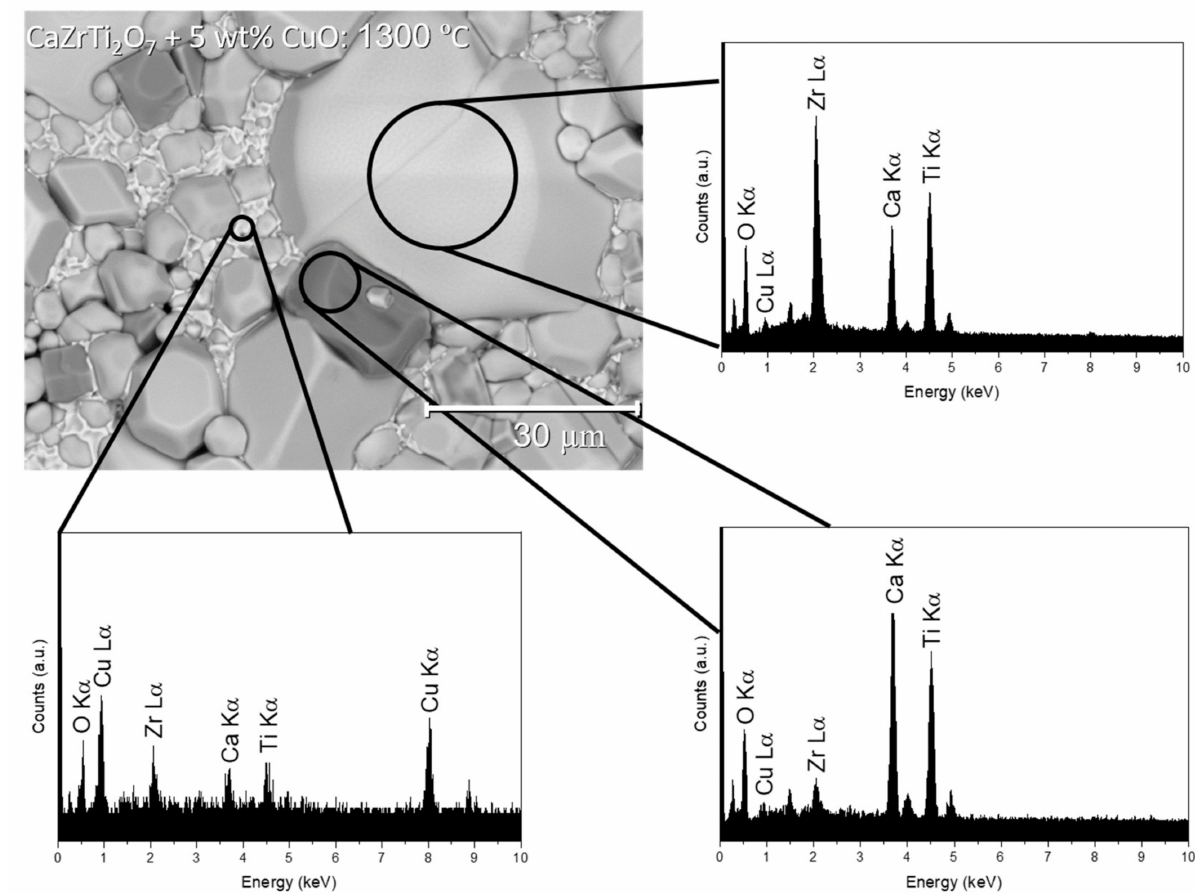
Figure 5. SEM/EDS analysis of CaZrTi 2 O 7 + 5 wt.% CuO sintered at 1300 ◦